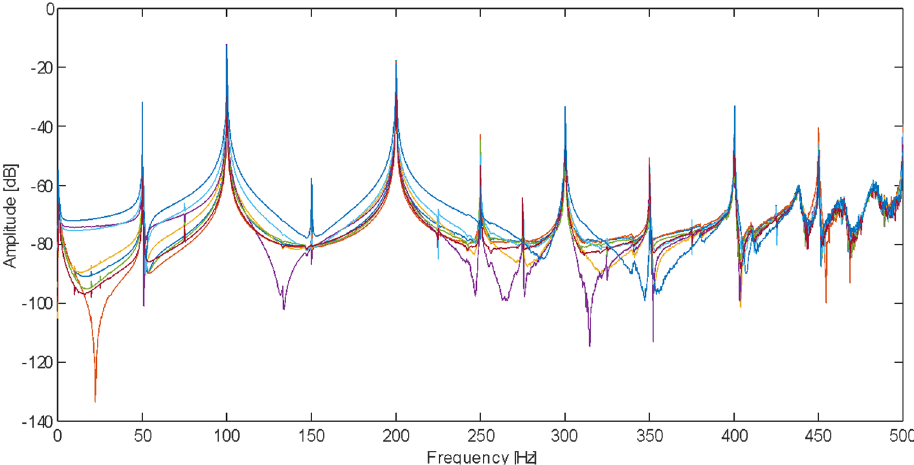
Figure 5. PSD functions at the first reference point from all partial experiments.